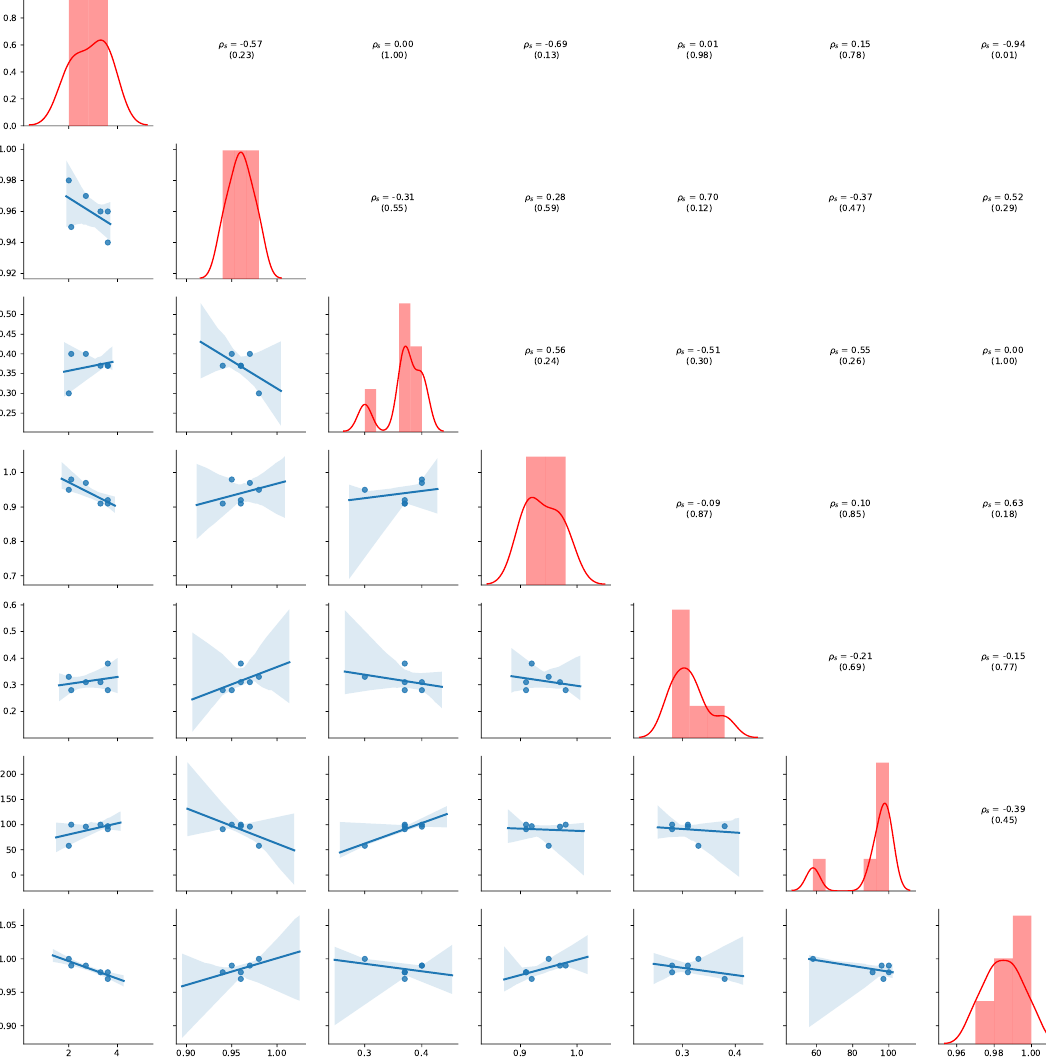
Figure A2. Relation of non-aggregated measures for MIMIC. Based on measures reported in Table 3. Diagonal: normalized histogram and kernel density estimation of the distribution. Lower triangle: scatterplot with estimated linear regression line. Upper triangle: pairwise Spearman’s rank correlations with p